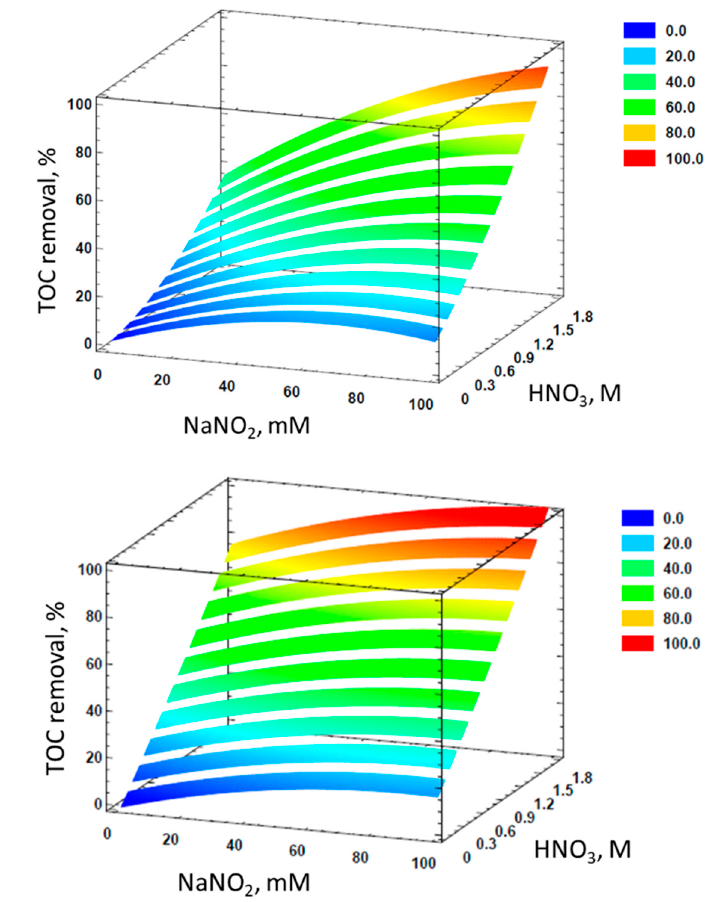
Figure 3. Response surfaces to assess the effect of the concentration of both NaNO 2 and HNO 3 on TOC removal after ( a ) 30 and ( b ) 120 min of treatment, at a fixed temperature of 85 °C.